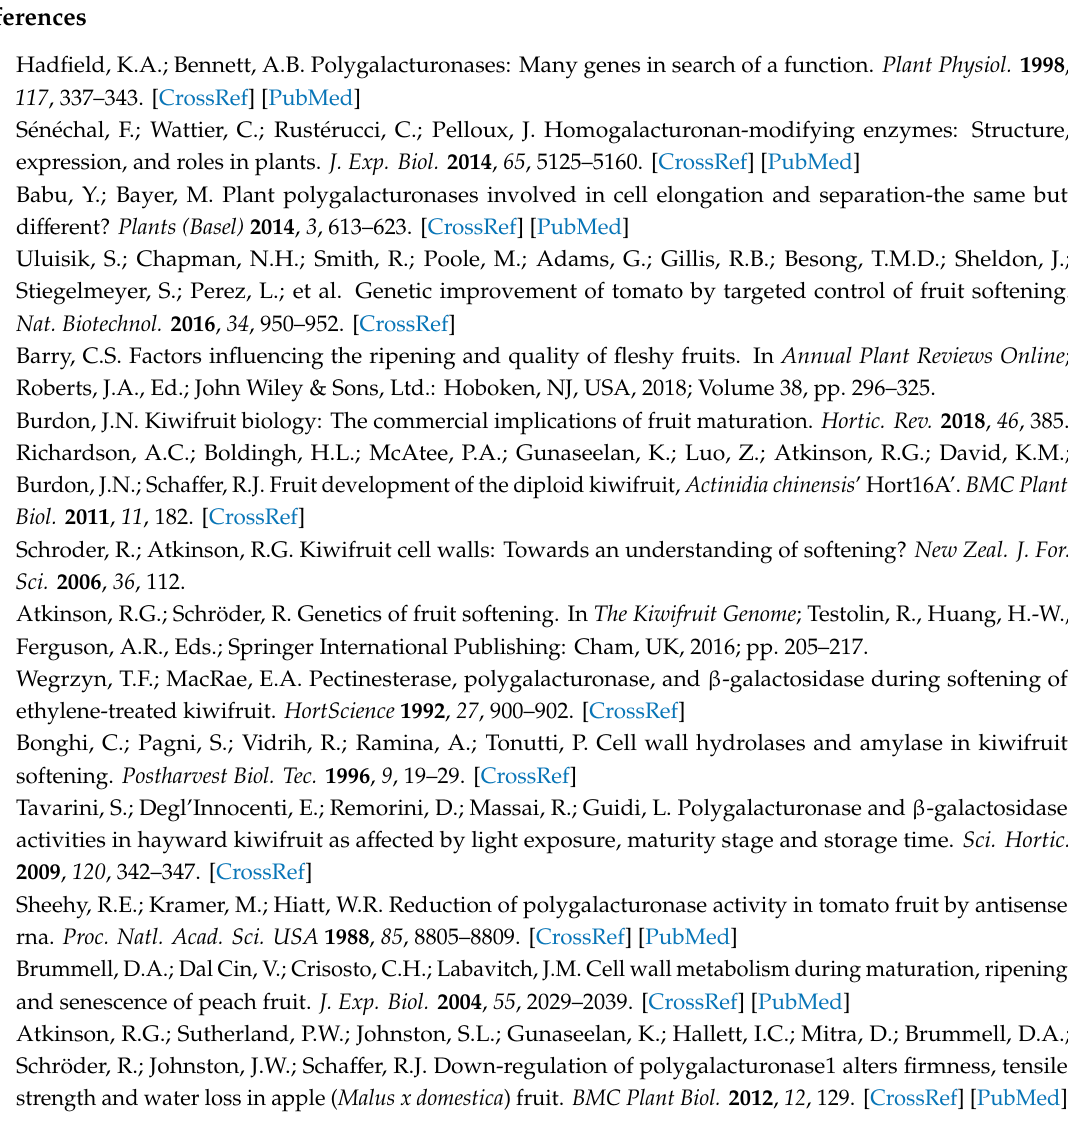
Figure S1 . PG family in chr map. Table S1 . Motifs information identified by MEME from 51 PG proteins of Table S3 . qPCR results of 26 AcPG genes during kiwifruit ‘Donghong’ softening. Table S4 . Correlation analysis of gene expression and enzyme activity of AcPGs during ‘Donghong’ softening. Table S5 . List of primers used for qPCR assay of AcPG